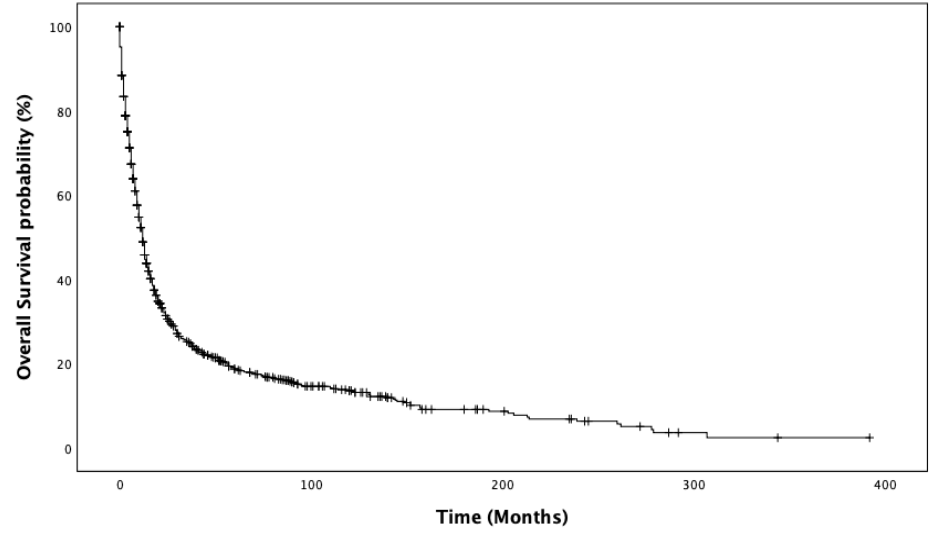
Figure 1. Kaplan–Meier estimates of overall survival.